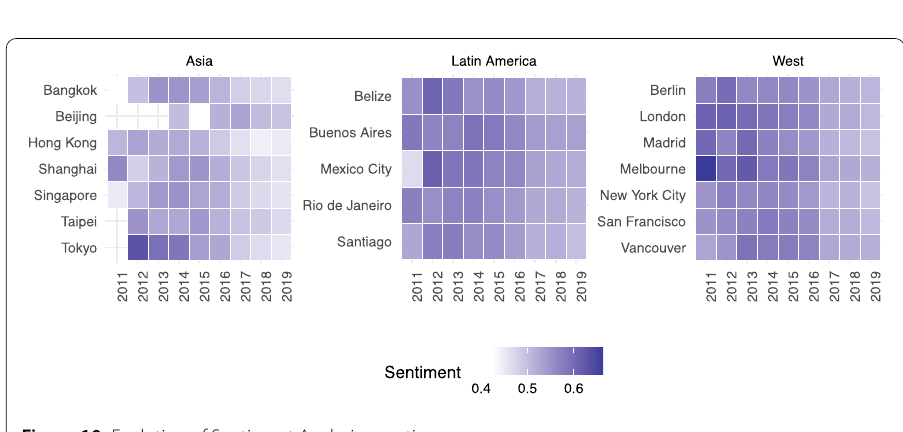
Figure 10 Evolution of Sentiment Analysis over